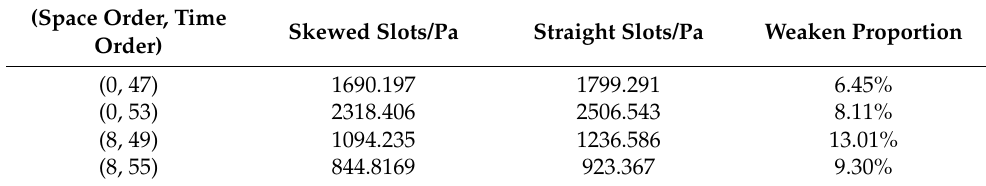
Table 4. Amplitude of excitation force obtained by two-dimensional Fourier